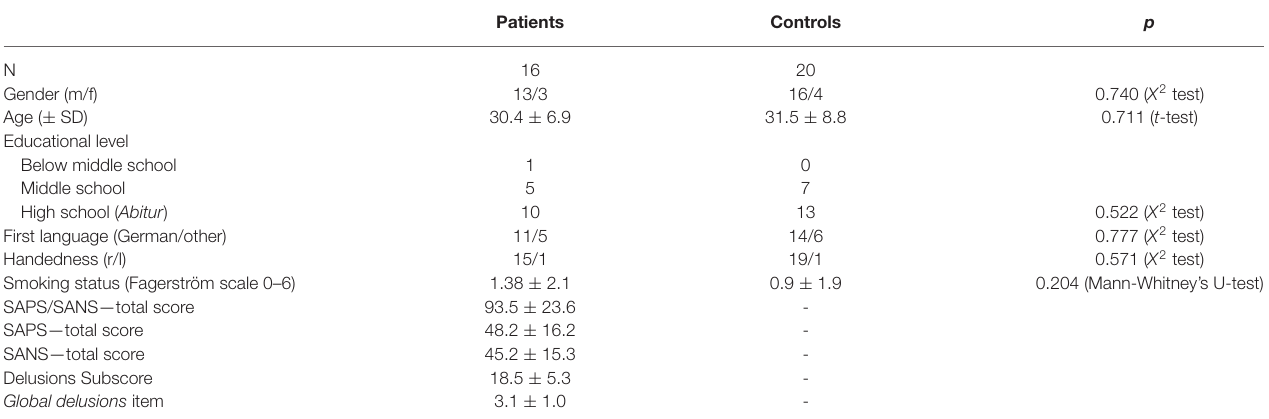
TABLE 1 | Demographic information .